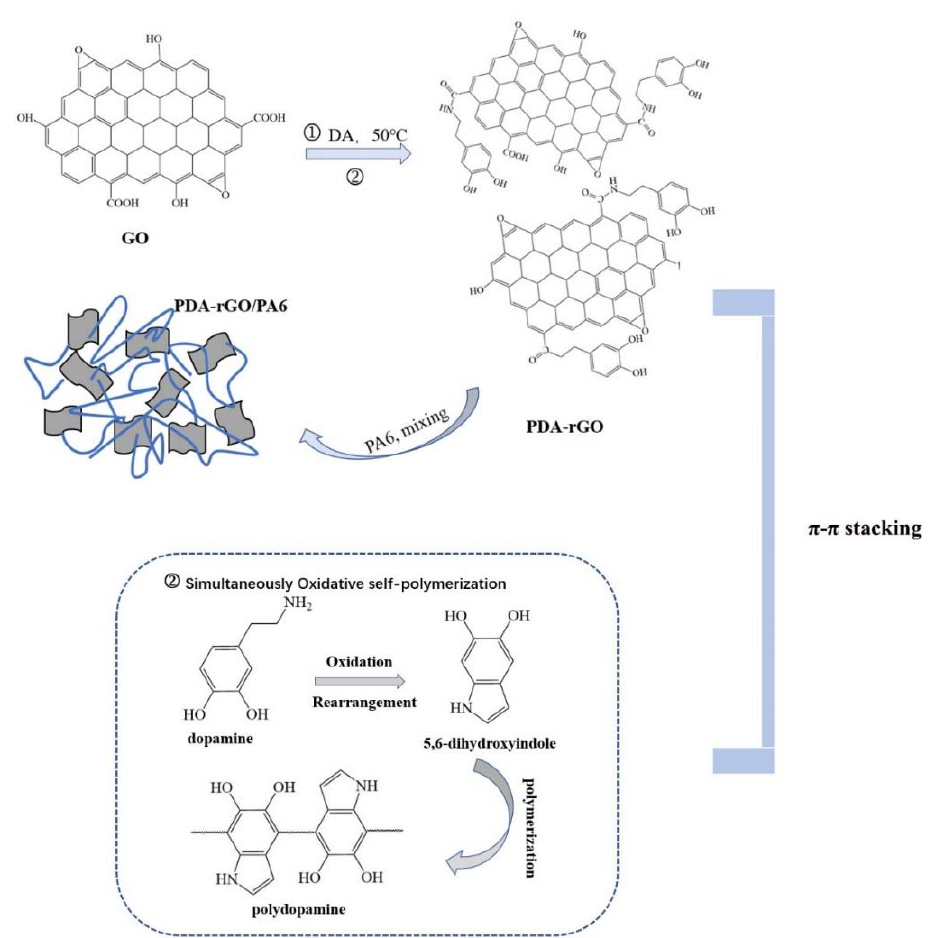
Figure 1. Schematic diagram of the synthesis process of PDA-rGO and PDA-rGO/PA6 composites.